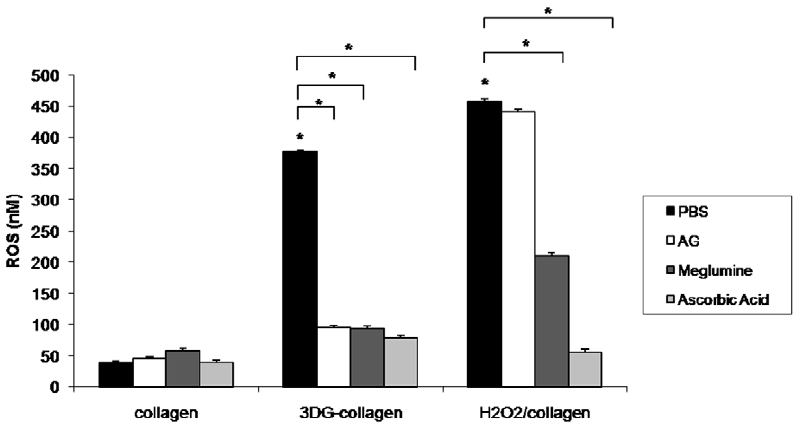
Figure 3. 3DG-collagen stimulates intracellular ROS in fibroblasts. Fibroblasts were cultured in 96-well plate coated with either native collagen or 1 mM 3DG-collagen or treated with or without 5 mM AG, 40 mM meglumine, or 100 m g/mL ascorbic acid for 24 h. Treatment of fibroblasts cultured on native collagen with 50 m M H 2 O 2 was used as a positive control. Fibroblasts were loaded with DCFH-DA for 30 min and ROS production was measured by absorbance of fluorescent DCF at a wavelength of 480 nm/530 nm. Comparisons are made to collagen treated with PBS unless otherwise indicated. Data are mean 6 SD (n=3), *P , 0.001.